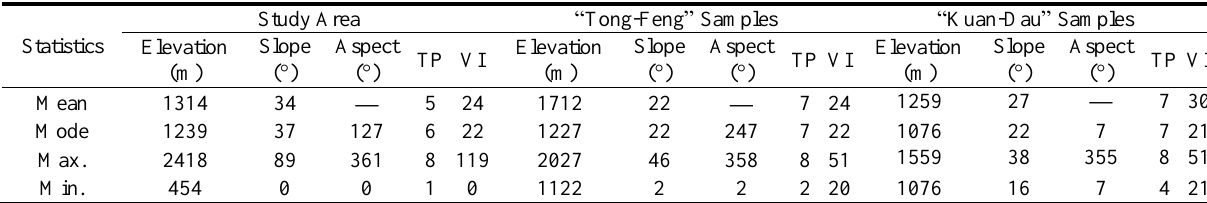
Table 1. The statics of environmental factors with study area and the samples of each watershed.